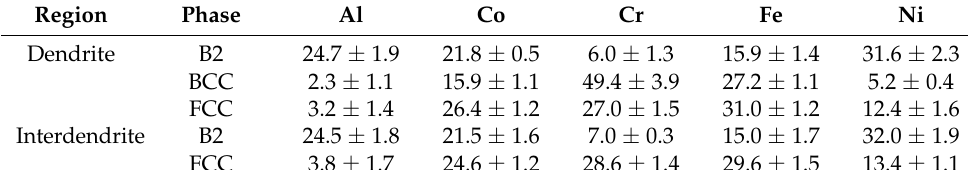
Table 3. Chemical composition (at.%) of the interior phases marked in Figures 3 and 4. Table 4. Chemical composition (at.%) and volume fraction (%) of the interior phases marked in Figure 5. Region